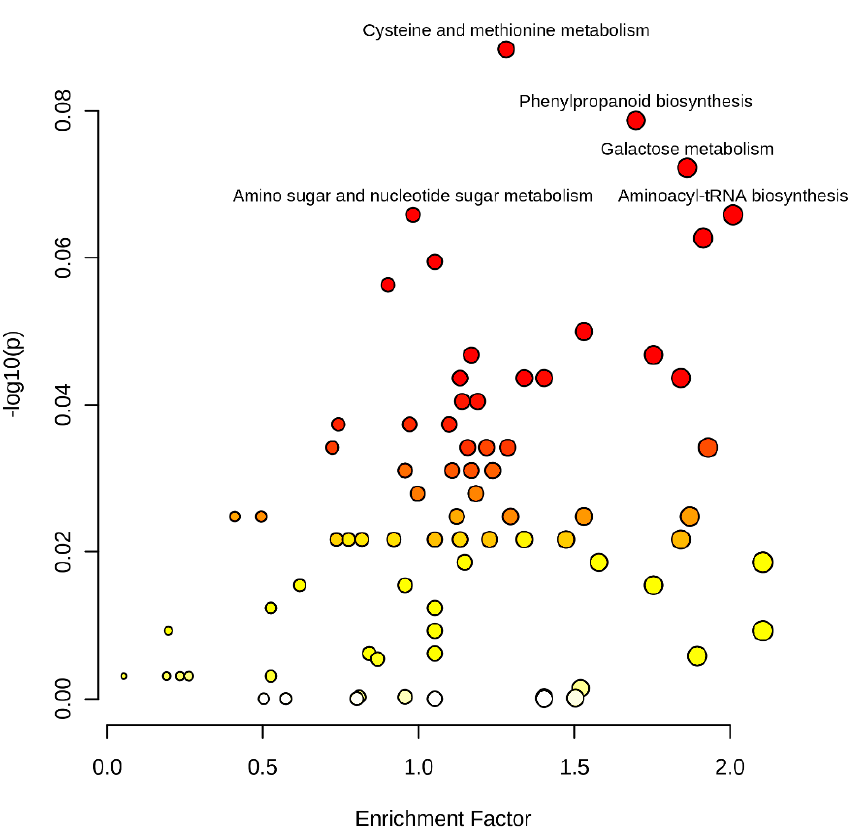
Figure 2. Metabolite pathway analyses showing metabolite enrichment and variation in pearl millet lines originated using the mummichog algorithm.